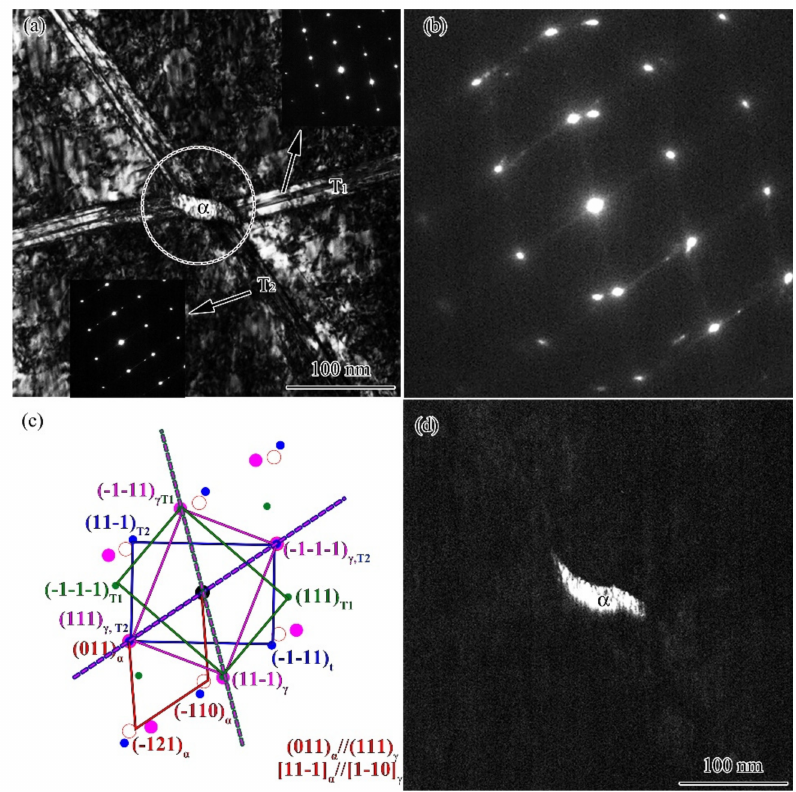
Figure 6. TEM bright filed image ( a ), SAED pattern ( b ), the indexed sketch map ( c ), and the dark